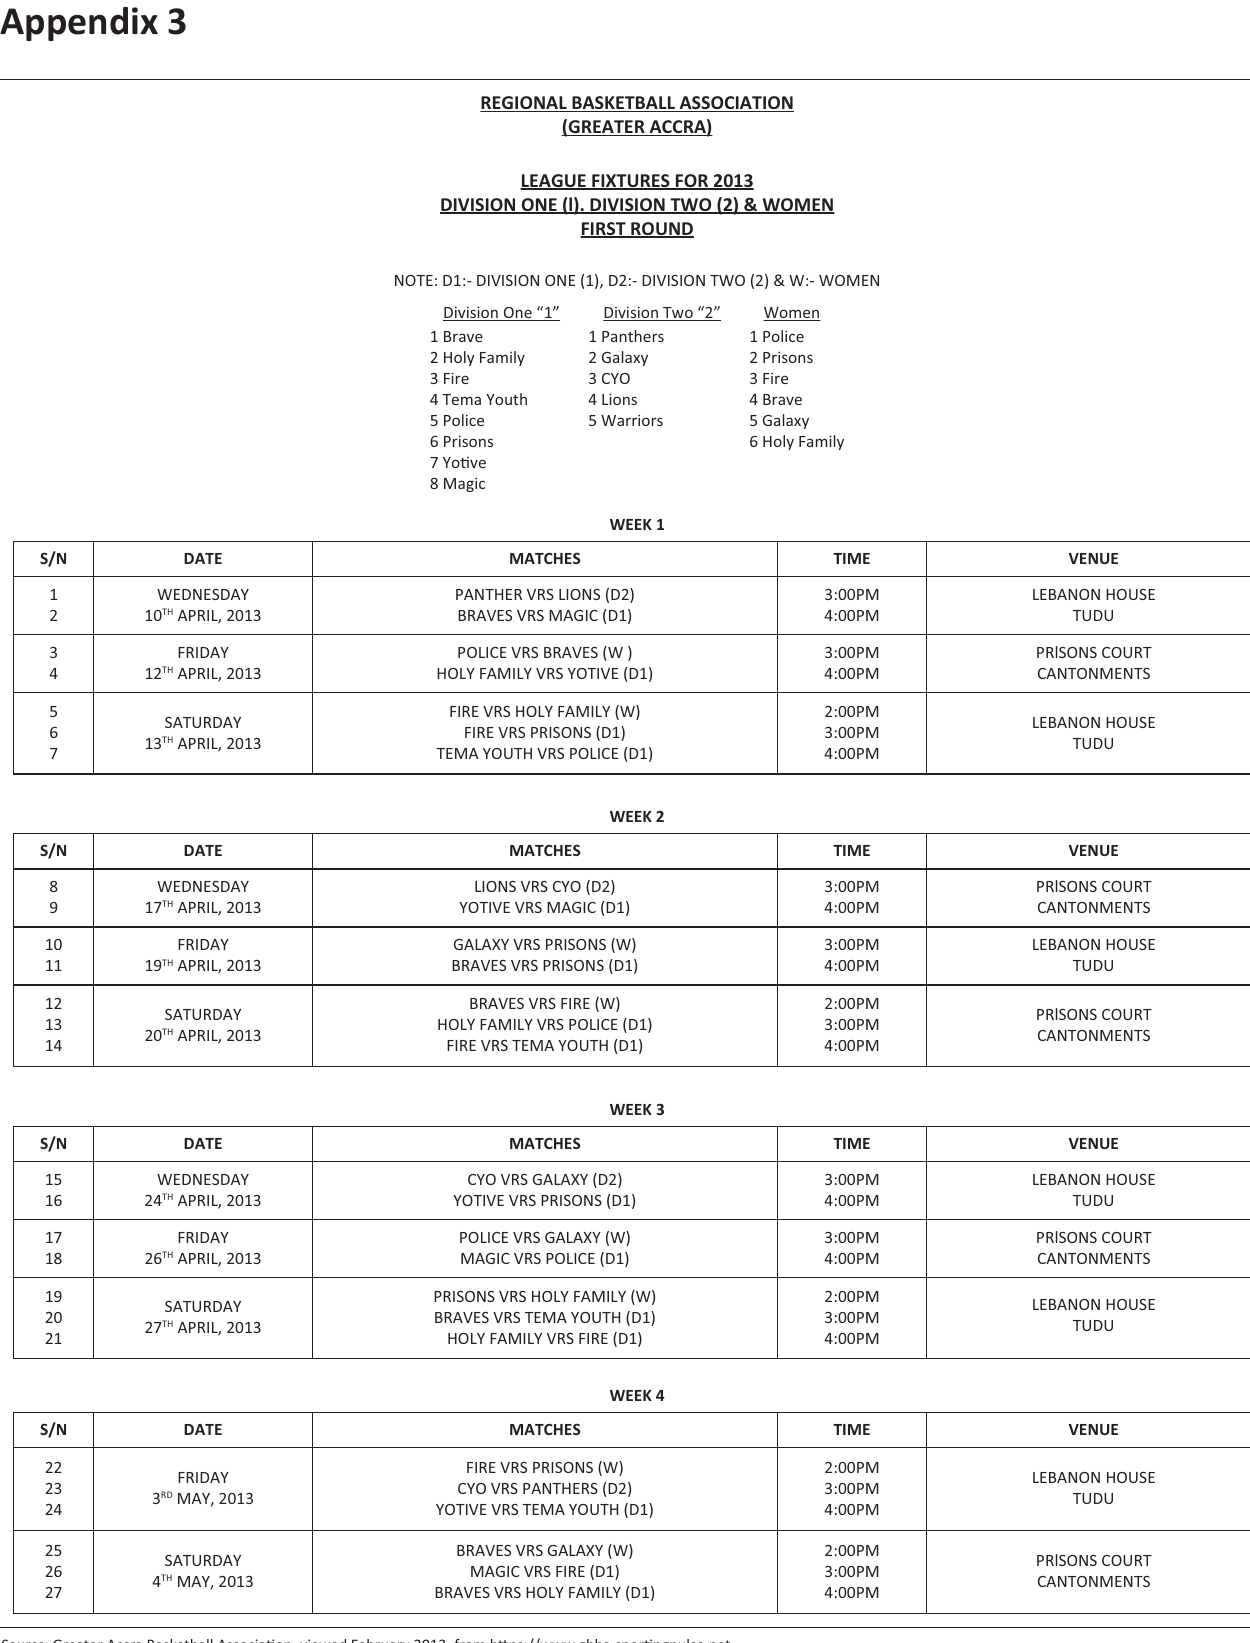
Source : Greater Accra Basketball Association, viewed February 2013, from https://www.gbba.sportingpulse.net FIGURE 1-A3: League